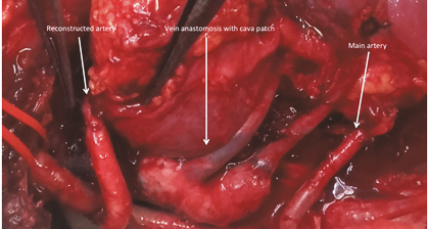
Figure 7: Close look at all three vascular anastomoses after